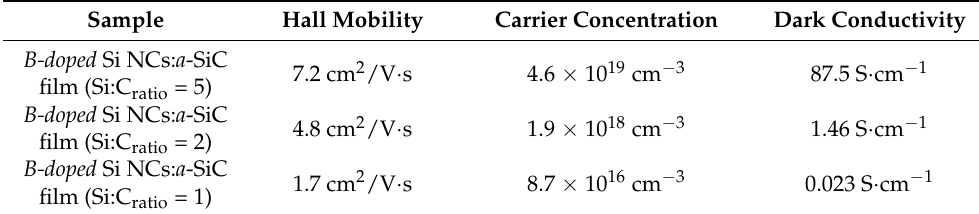
Table 1. Room temperature Hall measurement.